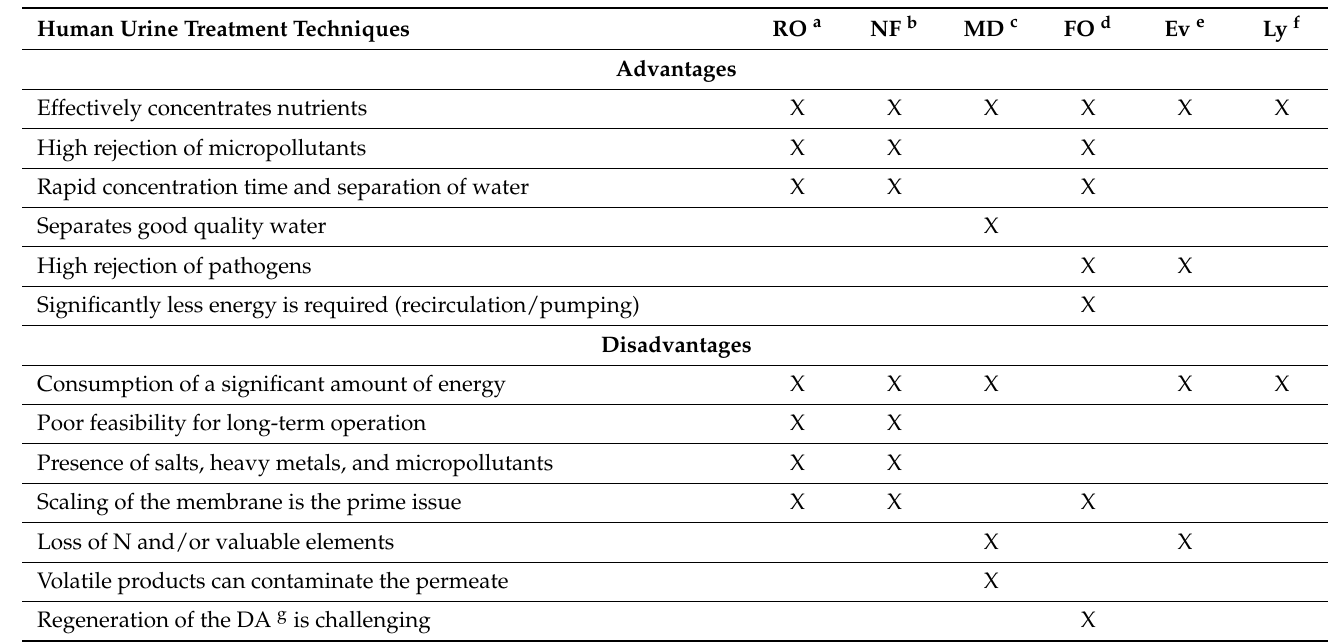
Table 2. Available human urine treatment techniques advantages and